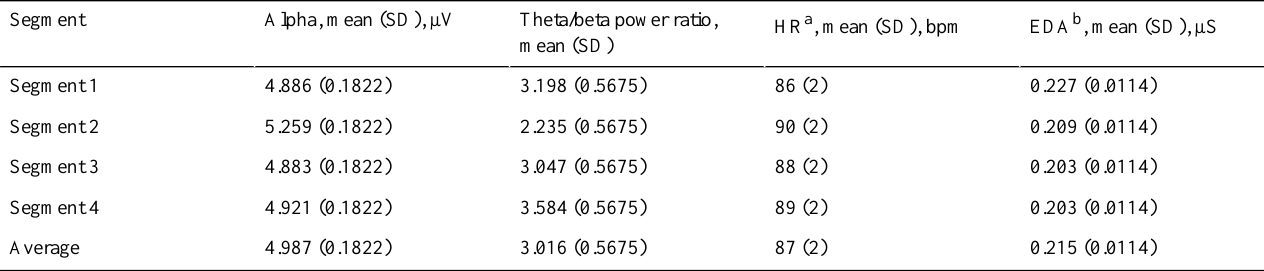
Table 1. Biosignal baseline averages of a representative participant (neurosurgeon) during the conventional educational episode.